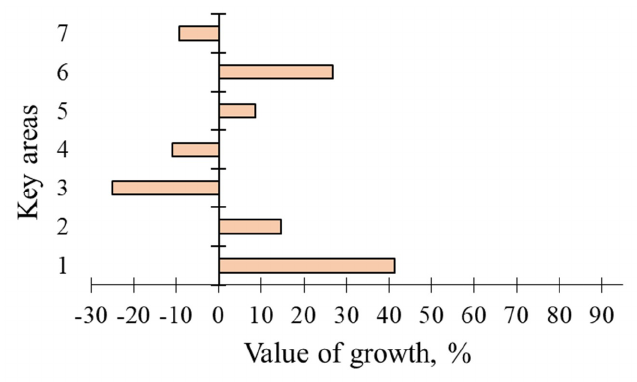
Figure 11. The dynamic pattern of the horizontal dissection of the ephemeral gully network (the Mesha river basin) in the period from 1988 to 2015.